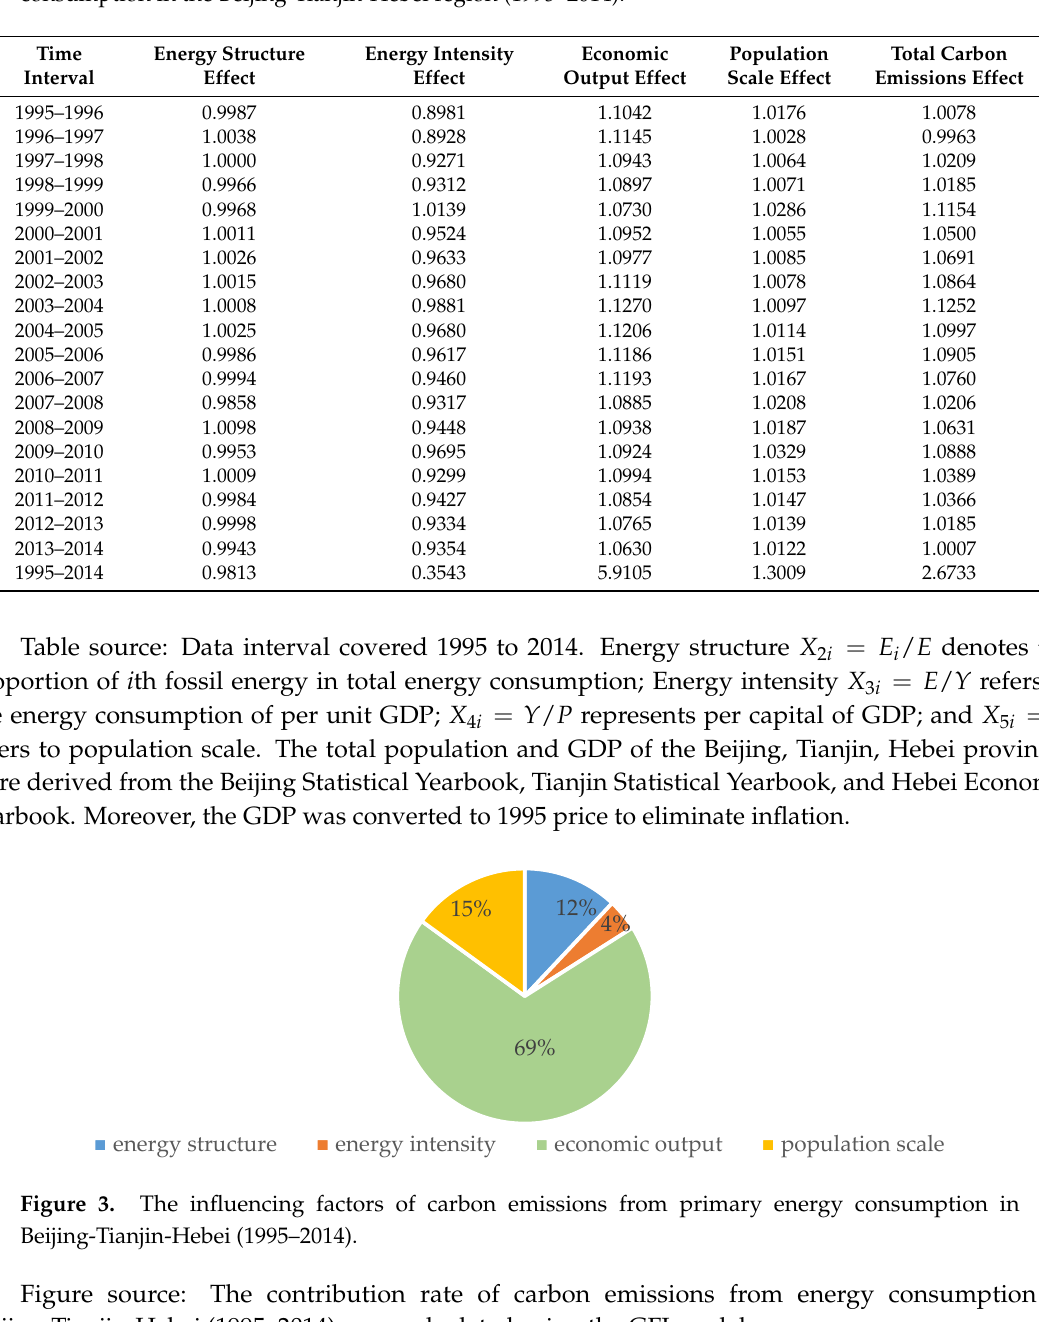
Table 3. Annual decomposition analysis results of changes in carbon emissions from energy consumption in the Beijing-Tianjin-Hebei region (1995–2014).